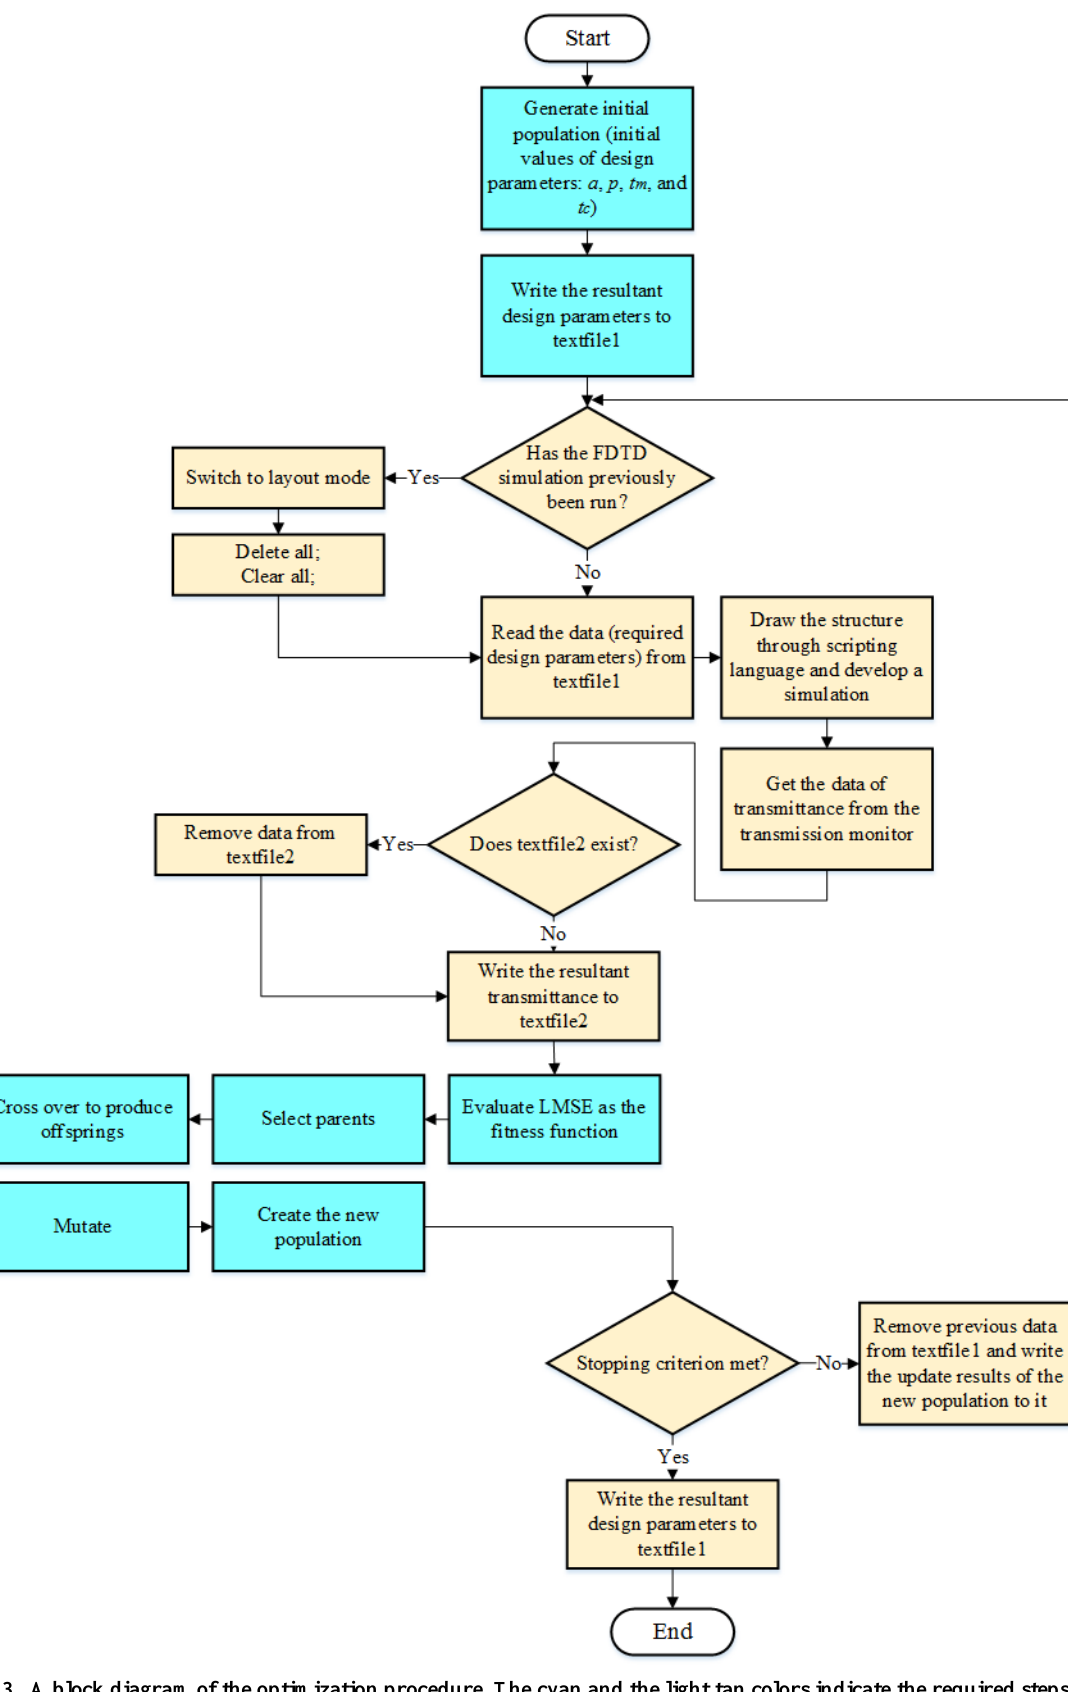
Figure 3. A block diagram of the optimization procedure. The cyan and the light tan colors indicate the required steps in Matlab and FDTD Solutions,